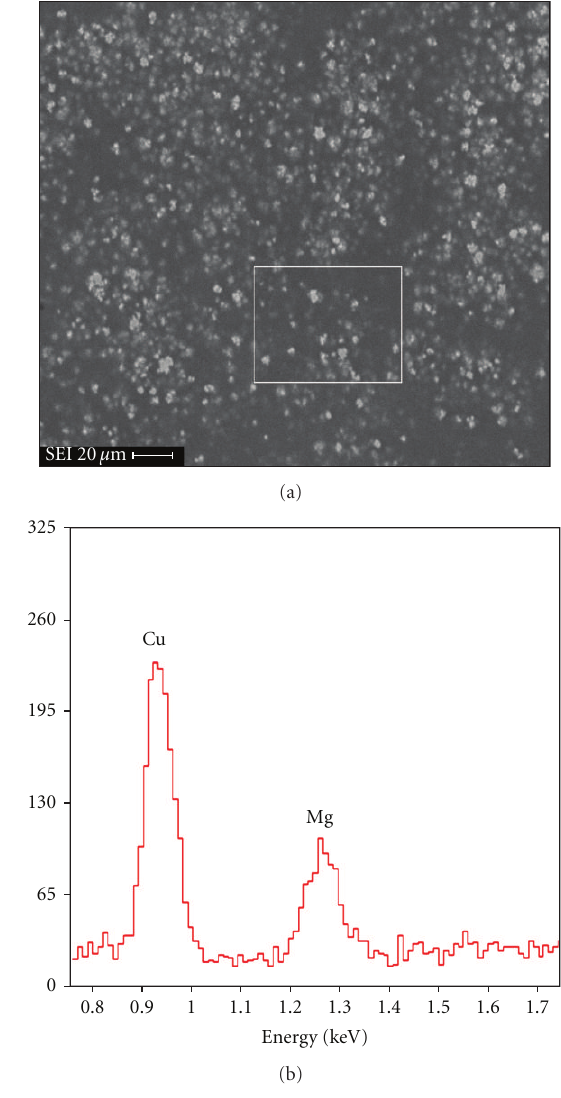
Figure 6: Typical cyclic voltammograms of Mg deposition- dissolution on Pt disk electrode from (a) BMMImBF 4 + THF (3:1), (b) 0.3molL − 1 Mg(CF 3 SO 3 ) 2 /BMMImBF 4 + THF (3: 1). The scanning rate was 50mVs − 1 .